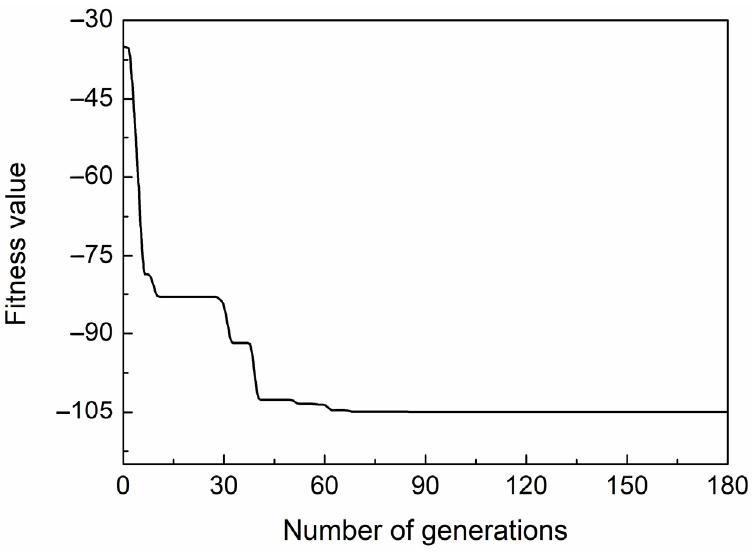
Figure 2. The change in the fitness value versus generation of GA.